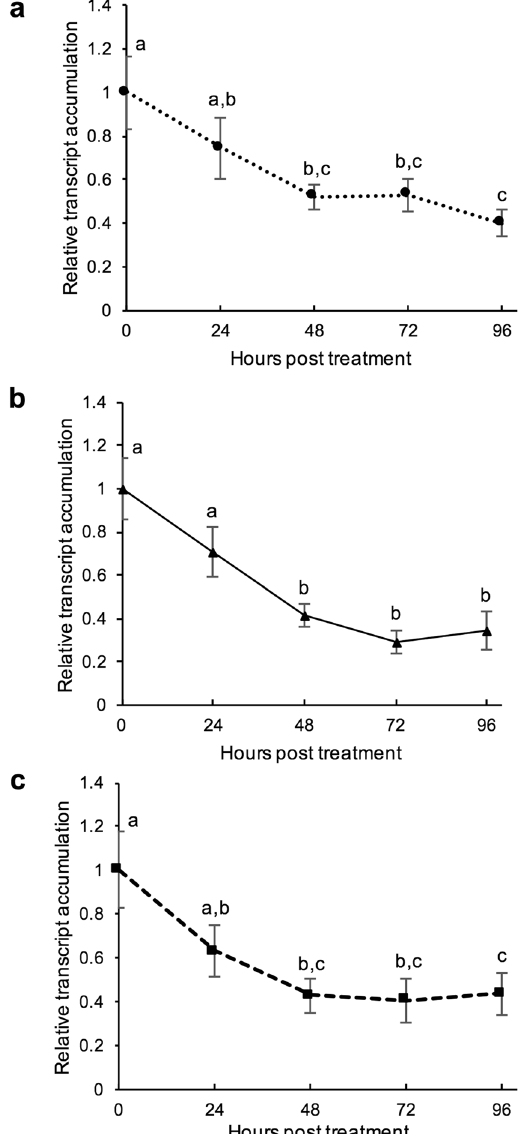
Figure 3. The timing of RNAi silencing in Sclerotinia sclerotiorum in vitro . Transcript levels were measured at time points 0, 24, 48, 72, and 96 hours post treatment of 500 ng/mL of dsRNA targeting SS1G_01703 ( a ), SS1G_05899 ( b ), SS1G_06487 ( c ), or GFP in liquid culture. Data are relative to GFP-dsRNA control and normalized to reference SsSac7 (SS1G_12350). Data represents 3 biological replicates with error bars representing standard error. To test effect of timing, a one-way ANOVA (with significance of p < 0.05) was performed and followed by a Tukey post hoc test to compare means, where significant differences (p tukey < 0.05) are denoted with differing